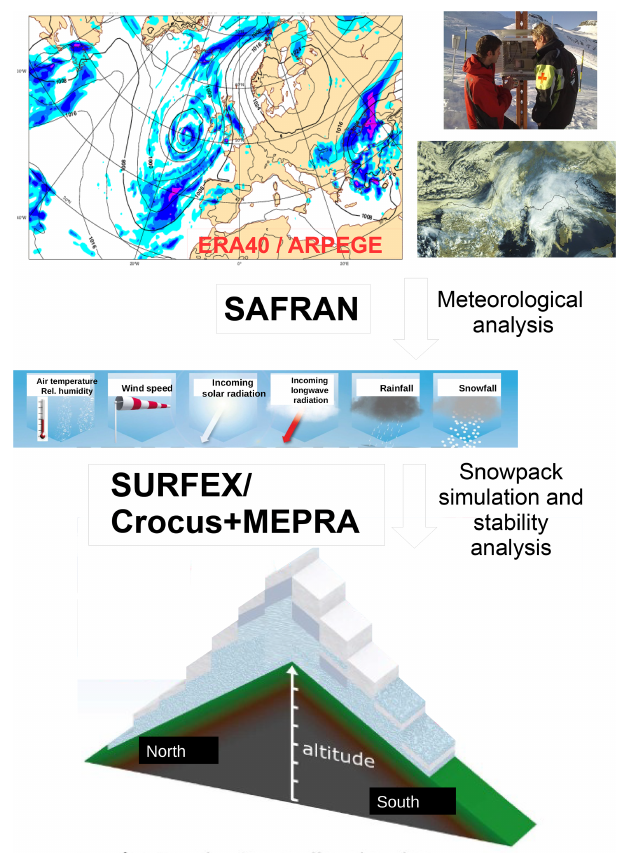
Figure 1. Description of the three steps of the reanalysis model chain: (1) NWP model (ERA-40 before 2002, ARPEGE from 2002 onwards); (2) assimilation and geometry adjustment by SAFRAN; and (3) snow cover model SURFEX/ISBA–Crocus, in- cluding